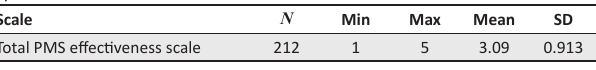
TABLE 4: Employees perceived effectiveness of the performance management